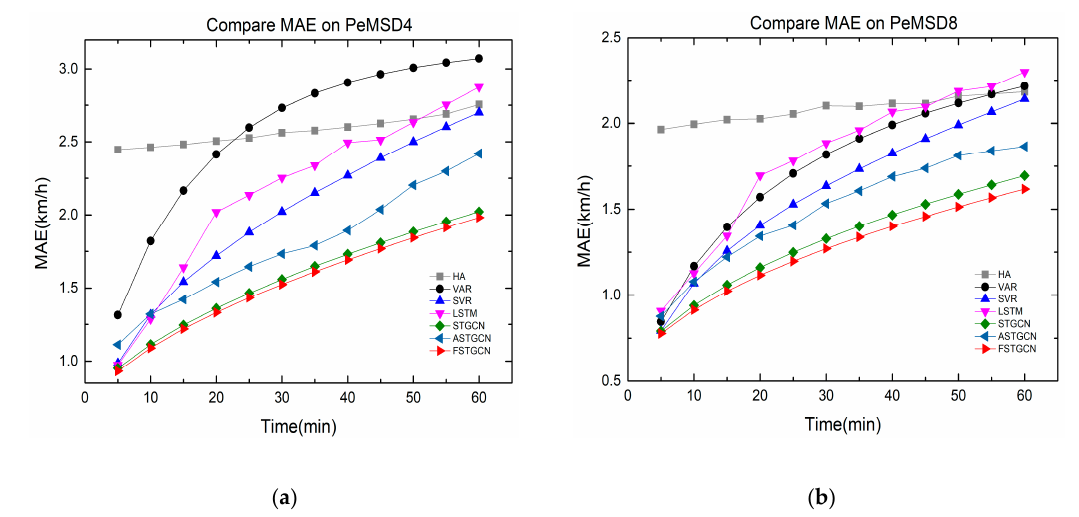
Figure 5. Performance comparison of various methods. ( a ) PeMSD4. ( b ) PeMSD8.